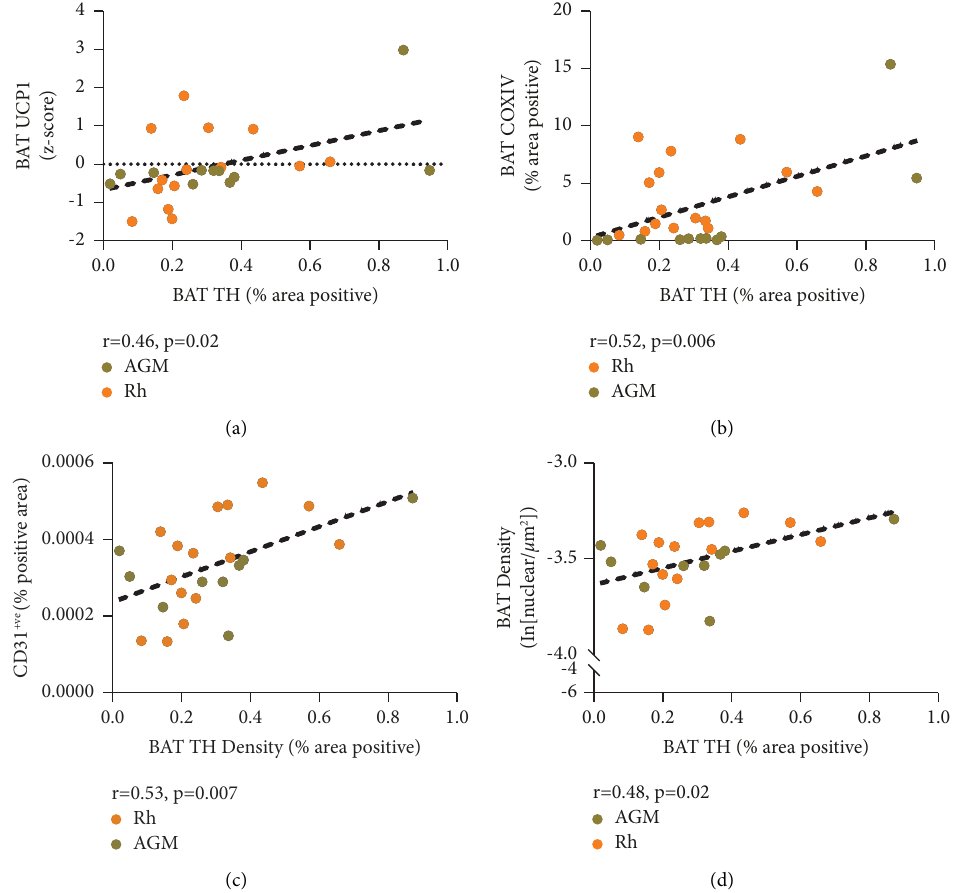
Figure 2: Signifcant histological features and BAT density correlates of tyrosine hydroxylase density. Panel (a) depicts the positive correlation between uncoupling protein 1 (UCP1) and tyrosine hydroxylase (TH) ( p value � 0.02, r � 0.46, n � 26). Panel (b) depicts the positive correlation between cytochrome c oxidase subunit 4 (COX IV) and TH ( p value � 0.006, r � 0.52, n � 26). Panel (c) depicts the positive correlation between cluster of diferentiation 31 (CD31) and TH ( p value � 0.007, r � 0.52, n � 24). Panel (d) depicts the positive correlation between brown adipose tissue (BAT) cell density and TH ( p � 0.02, r � 0.48, n �